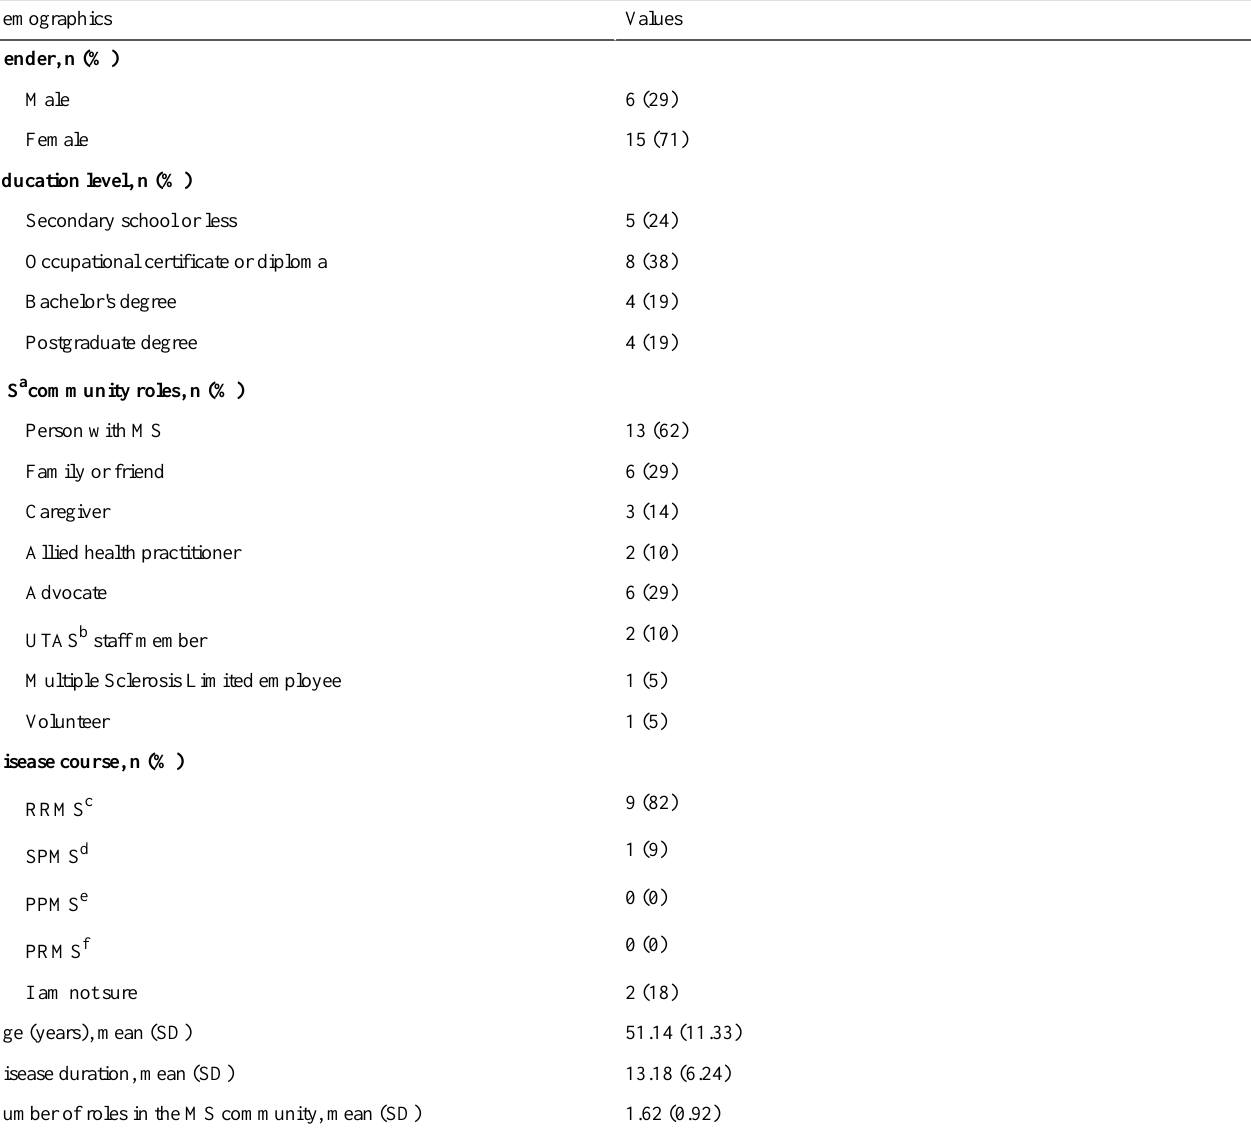
Table 1. Demographics of the focus group (n=21). Participants were able to select more than one multiple sclerosis (MS) community role and MS disease